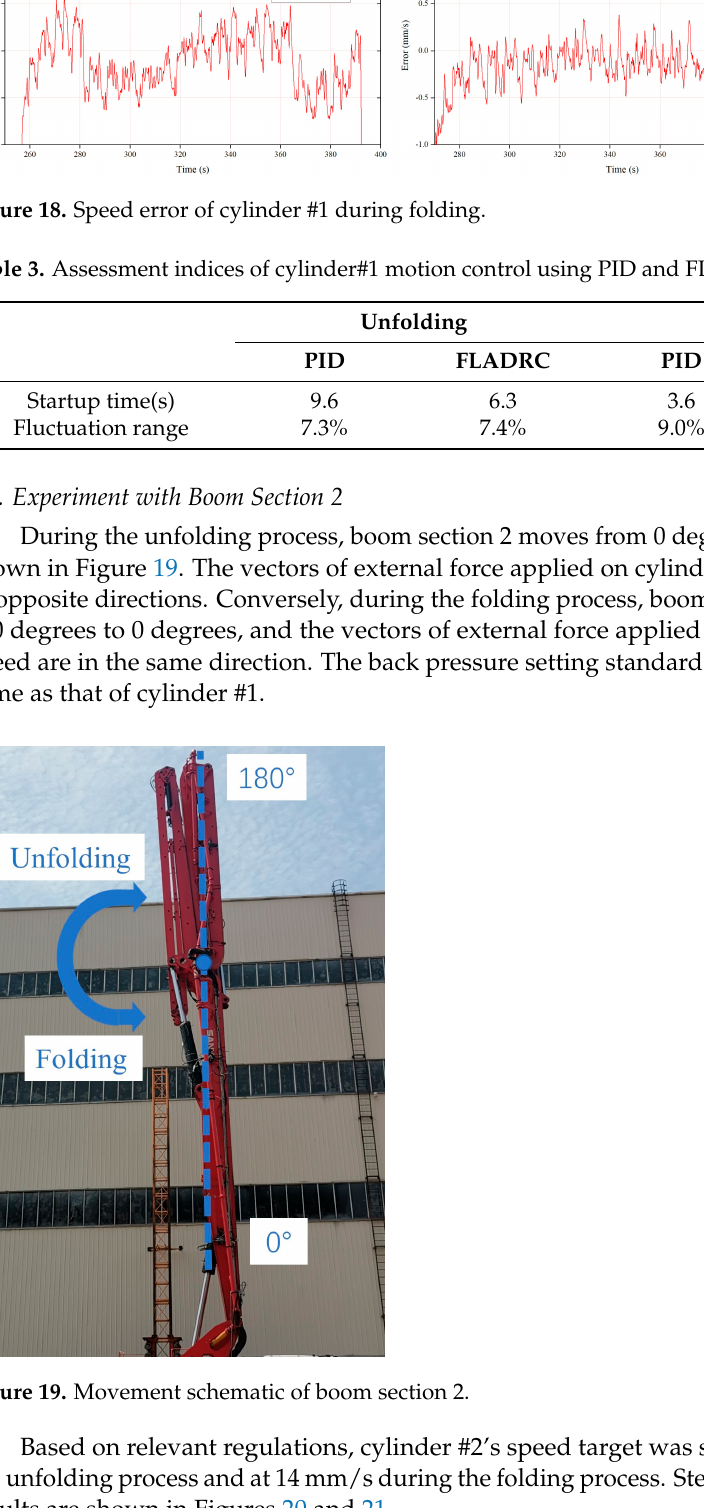
Figure 18. Speed error of cylinder #1 during folding.